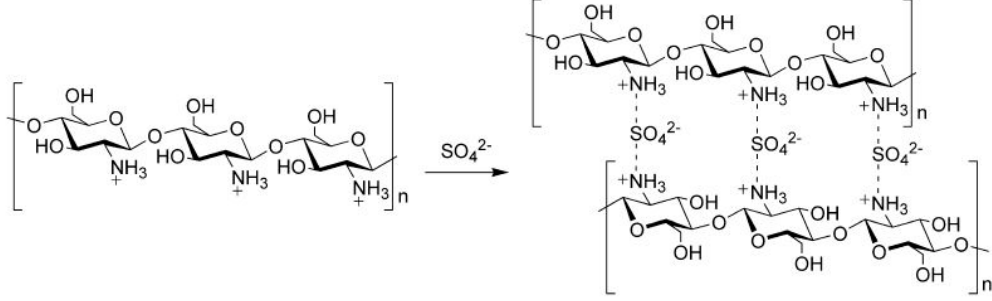
Figure 14. Chemical structure of CS cross-linked with sulphuric acid [189]. Copyright 2008, reproduced with permission from Elsevier